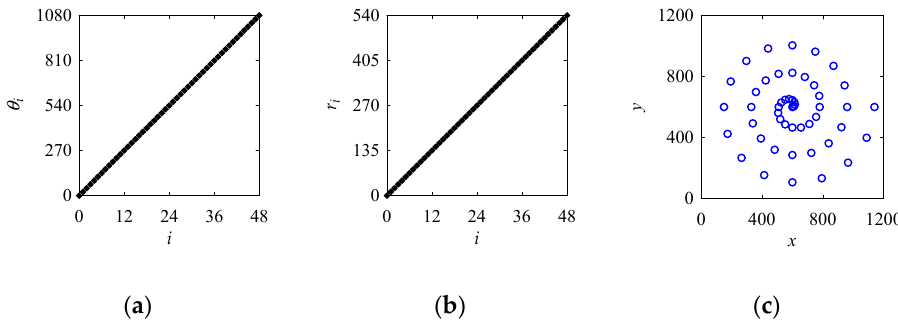
Figure 5. Settings for a spiral using the PCA. ( a ) Input1: θ i ; ( b ) Input2: r i ; ( c ) Output: Point cloud.